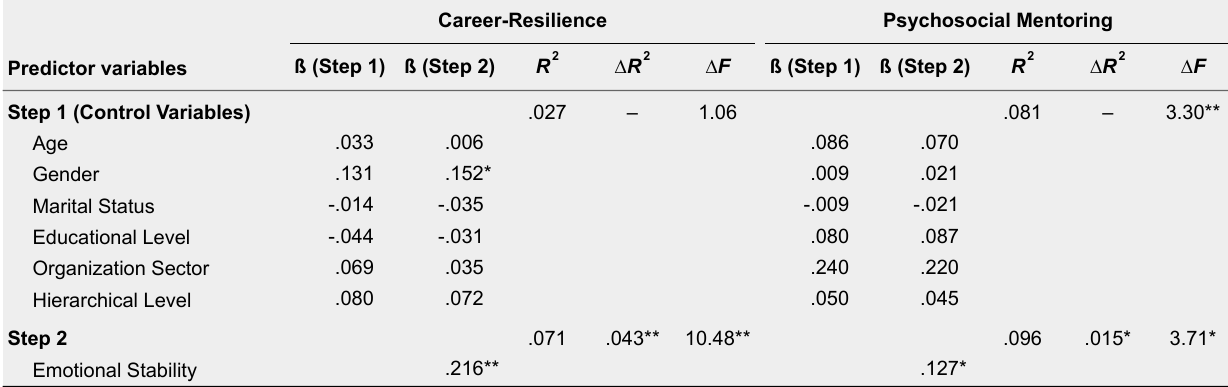
Psychosocial MentoringCareer-Resilience